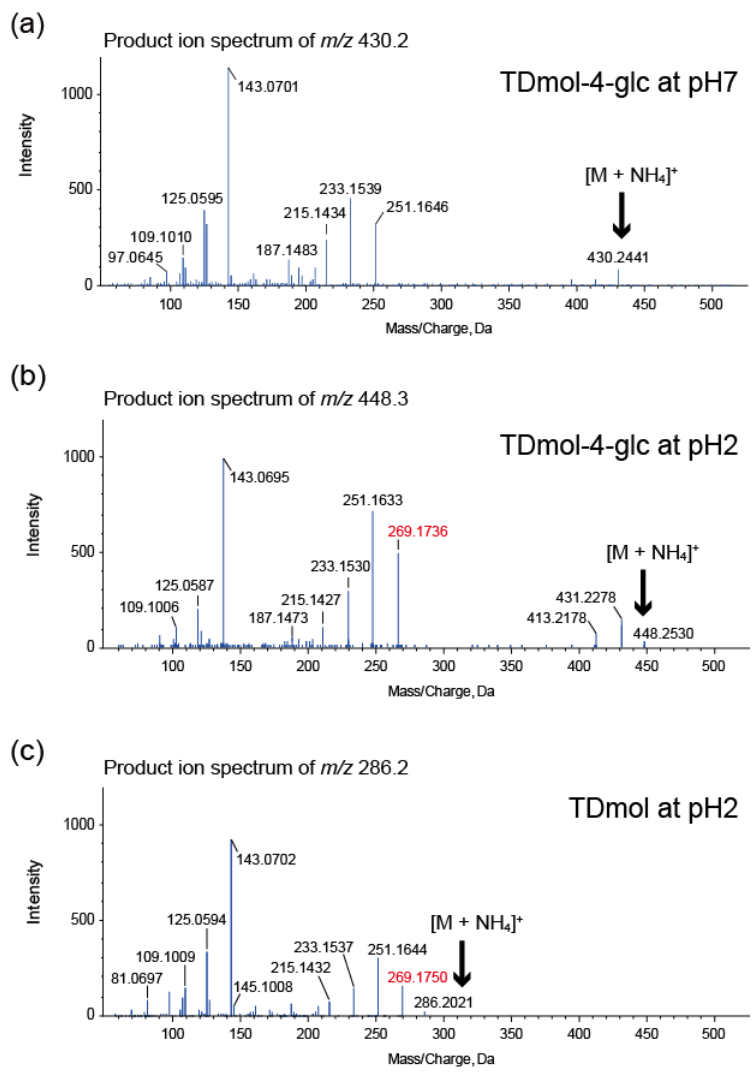
Figure 7. pH stability test of 1 . ( a ) MS/MS spectrum of the ammonium adduct ion of 1 incubated for 3 d at pH 7. ( b ) MS/MS spectrum of the ammonium adduct ion of 4 , which was partially formed by incubating 1 for 3 d at pH 2. ( c ) MS/MS spectrum of the ammonium adduct ion of trichodermol (TDmol) incubated for 3 d at pH 2.